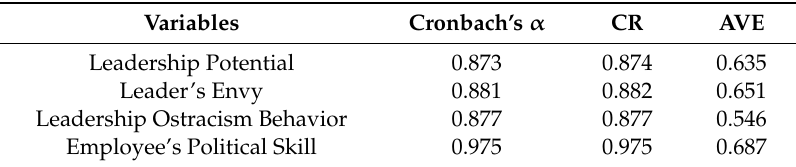
Table 2. Test results for reliability and validity of the